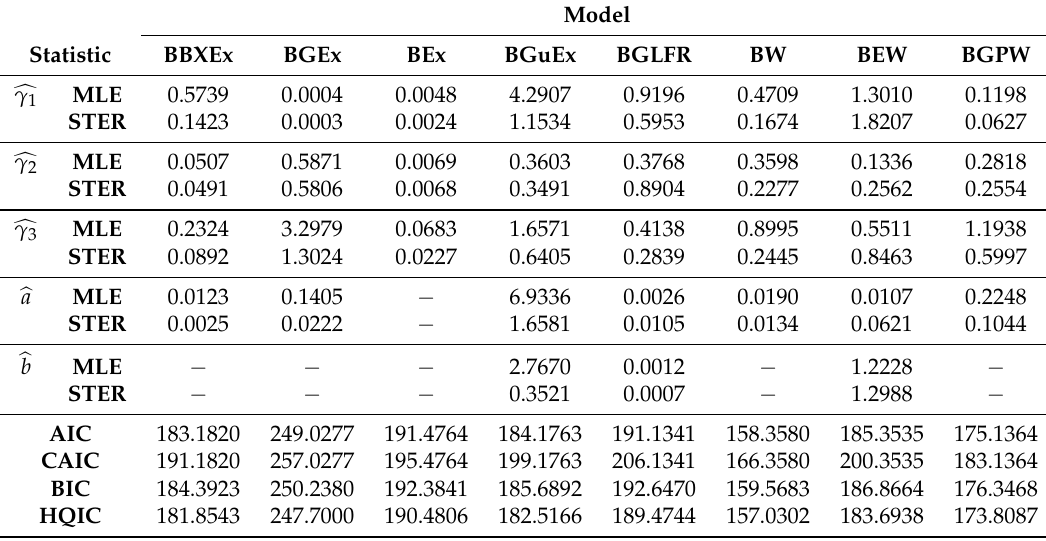
Table 9. The MLEs and goodness-of-fit measures based on Type-II censored data at r = 10 using data set I.